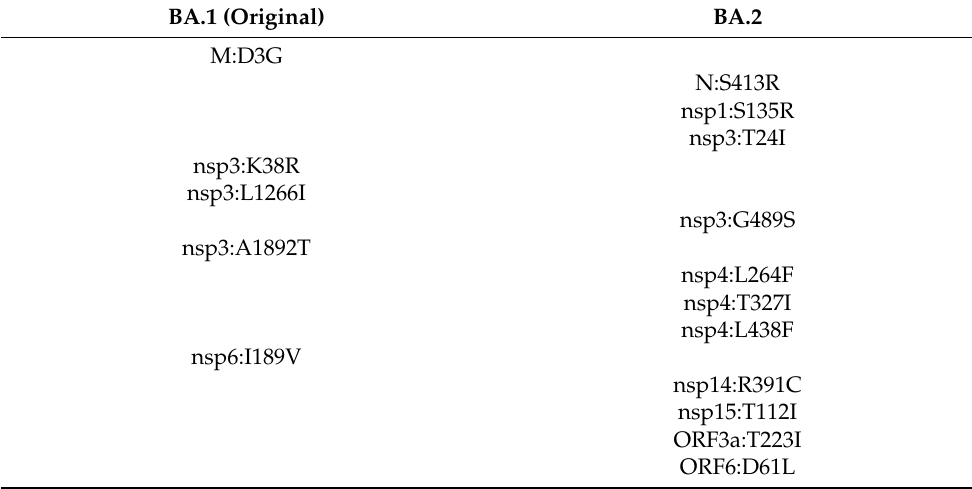
Table 3. Unique BA.1 and BA.2 mutations in genes other than